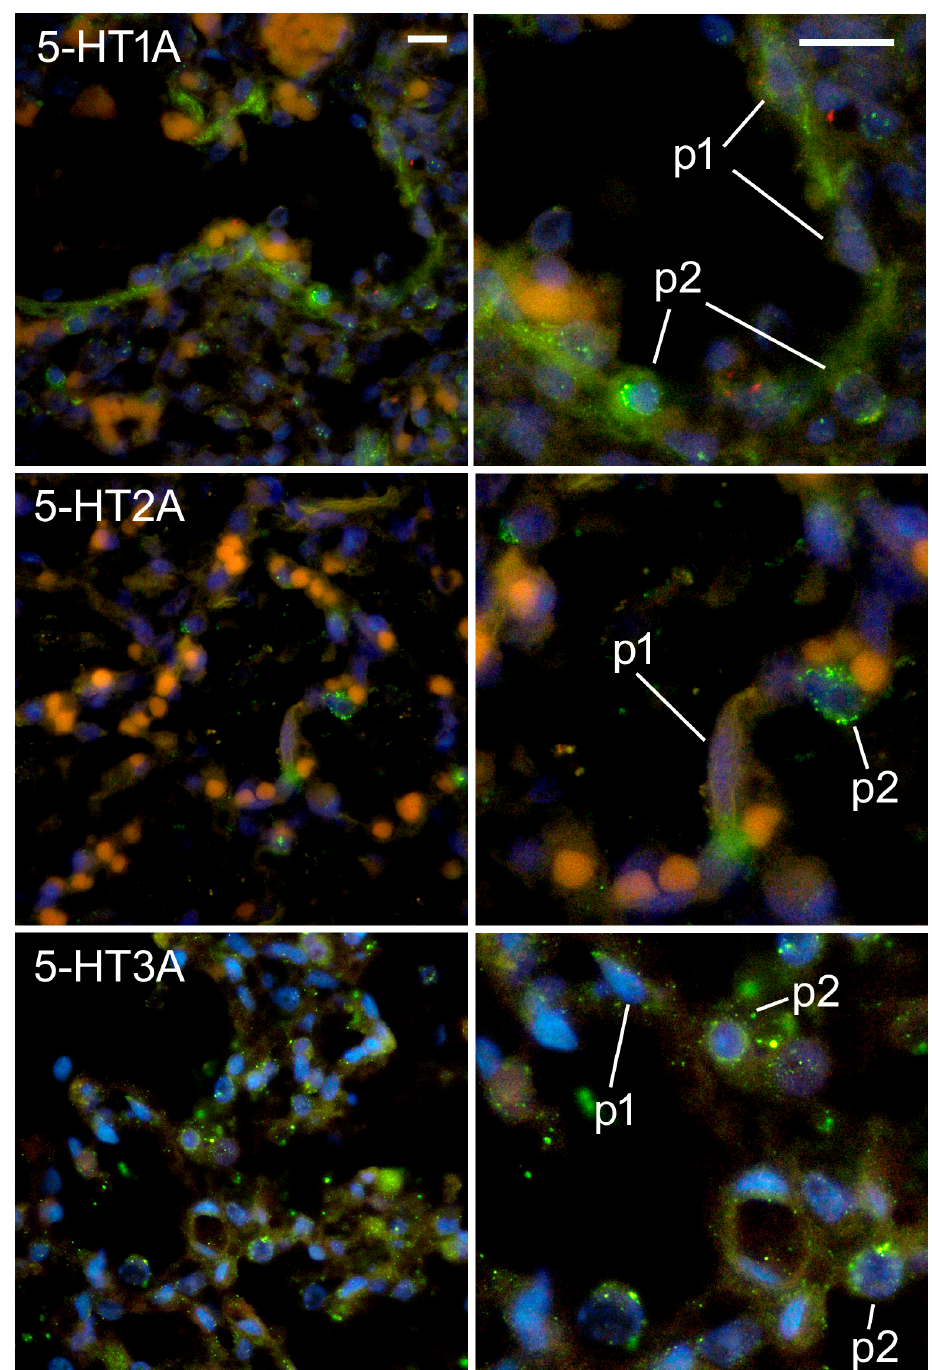
Figure 8. Immunofluorescence staining of fetal human lungs at the alveolar developmental stage with 5-HT1A, 5-HT2A, and 5-HT3A and CD31/PECAM markers. Nuclear DNA DAPI staining was combined with 5-HT1A. Green staining indicates positive 5-HT1A receptor expression, whereas blue staining indicates nuclear staining with 6-diamidino-2-phenylindole dihydrochloride (DAPI). Images were taken at 400 × ( left column) and 1000 × magnification ( right column). Scale bar = 20 µ m, see all images in the same column. p1—type I pneumocytes; p2—type II pneumocytes.